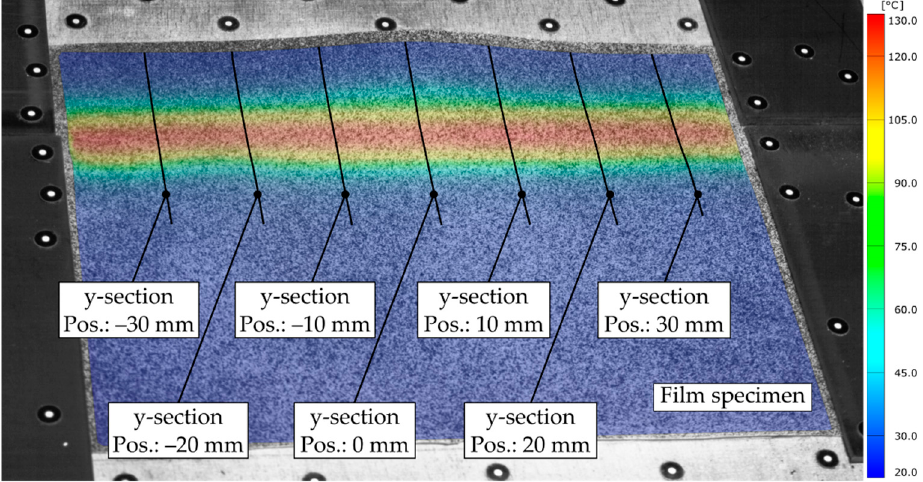
Figure 11. TPU-0.3-specimen with mapped temperature field and measurement sections (test No. 9, 𝑡 = 20.0 s).